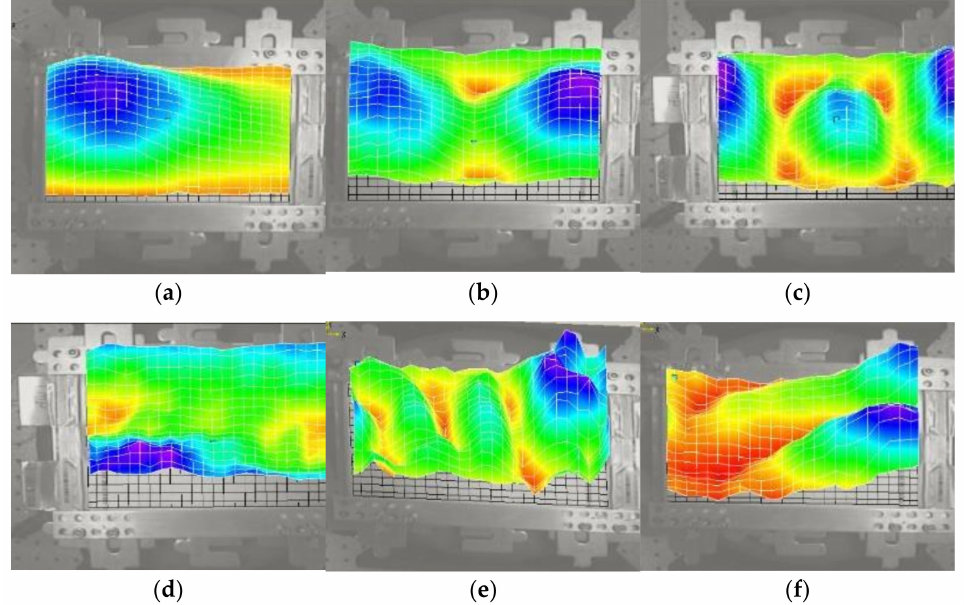
Figure 8. LIB mode shapes in boundary condition 2 shown in Figure 4b. ( a ) mode shape 1–first bending, ( b ) mode shape 2–first torsion, ( c ) mode shape 3–second torsion, ( d ) mode shape 4–second bending, ( e ) mode shape 5–third bending, ( f ) mode shape 6–third torsion. The change in battery voltage is monitored during the vibration test. By